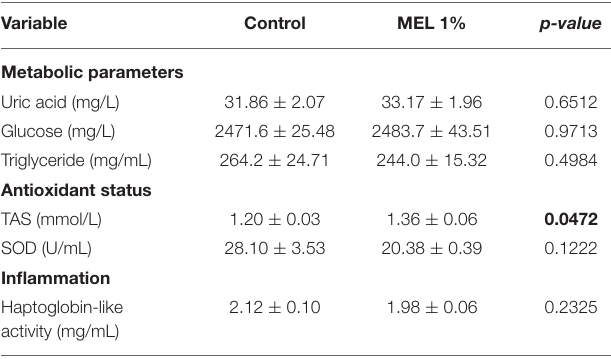
TABLE 9 | Effects of MEL extract supplementation on physiological parameters of blood from chickens reared under suboptimal starting conditions at D30.